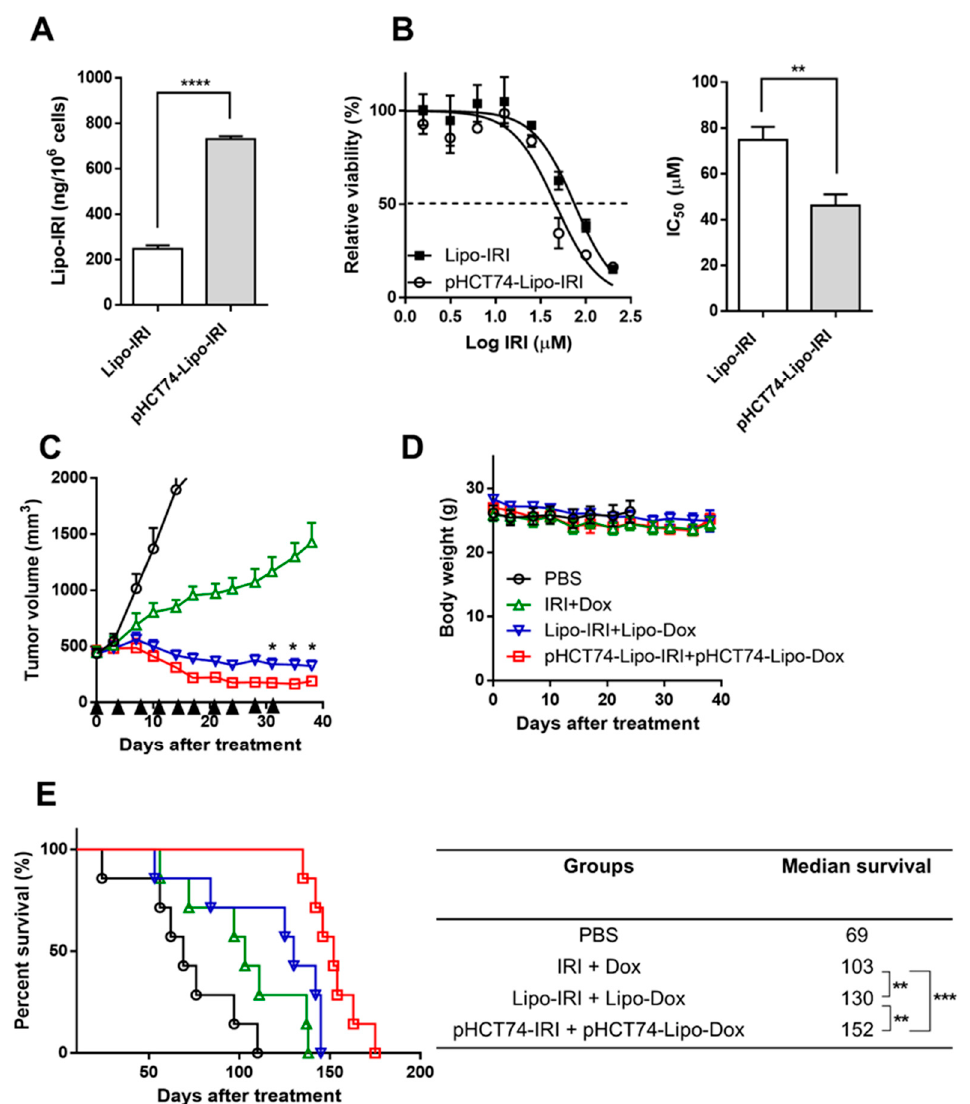
Figure 7. Enhanced effect of targeted liposome-encapsulated treatment combination in an hCRC large tumor model. The drug internalization ( A ) and cytotoxicity ( B ) of pHCT74-Lipo-IRI were compared with non-targeted Lipo-IRI in vitro. The tumor bearing mice (500 mm 3 ) received PBS, IRI + Dox, Lipo-Dox + Lipo-IRI, pHCT74-Lipo-IRI + pHCT74-Lipo-Dox 10 times over the course of 5 weeks (twice weekly × 5). The tumor volume and body weight are shown ( C and D ). A Kaplan-Meier curve and median survival of each group are shown ( E ). The data were analyzed by GraphPad Prism 6.0 software ( n = 7). * p < 0.05, ** p < 0.01, *** p < 0.001 and **** p <